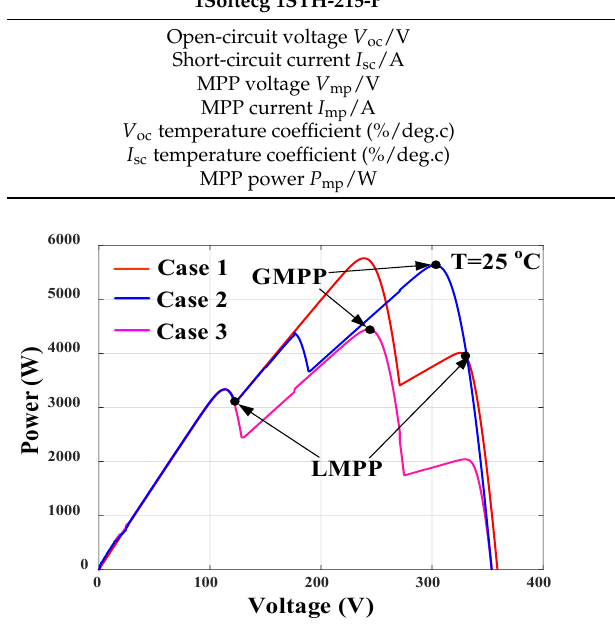
Figure 6. PV characteristic curve under PSC.